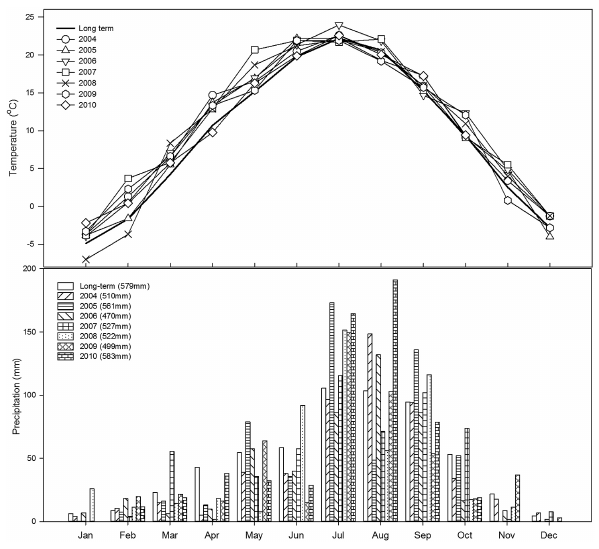
Figure 1. Mean monthly temperature and precipitation from 2004– 2010 and the long-term mean at the experimental site at Changwu Agricultural Research Station, Shaanxi Province, China.